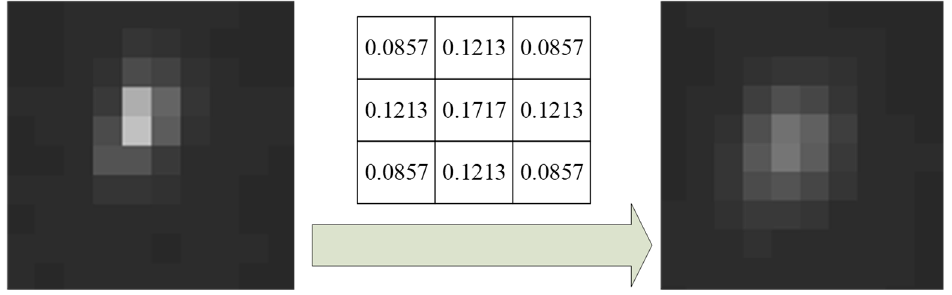
Figure 3. The result of traditional Gaussian filtering.